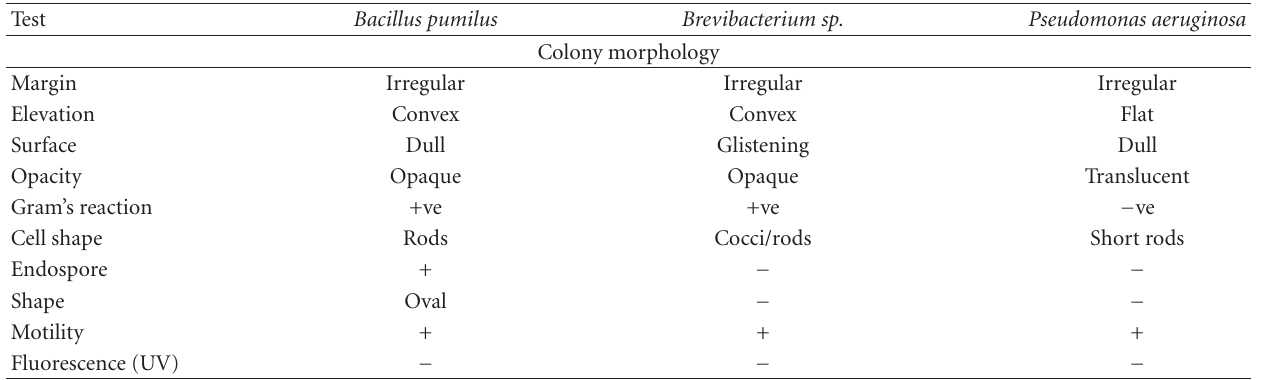
Table 2: Morphological characteristics of the identified strains.